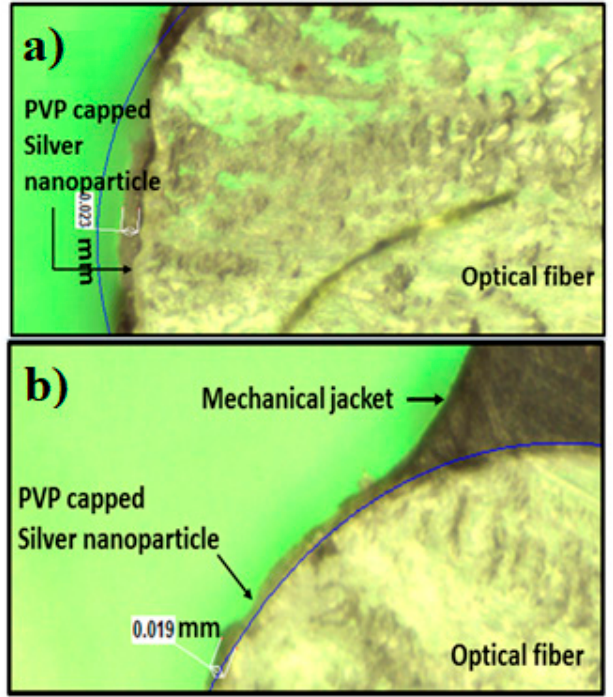
Figure 4. Optical images for cladding modified POF surfaces coated with PVP capped Ag-NPs synthesized by using ( a ) cold and ( b ) polyol synthesis methods.